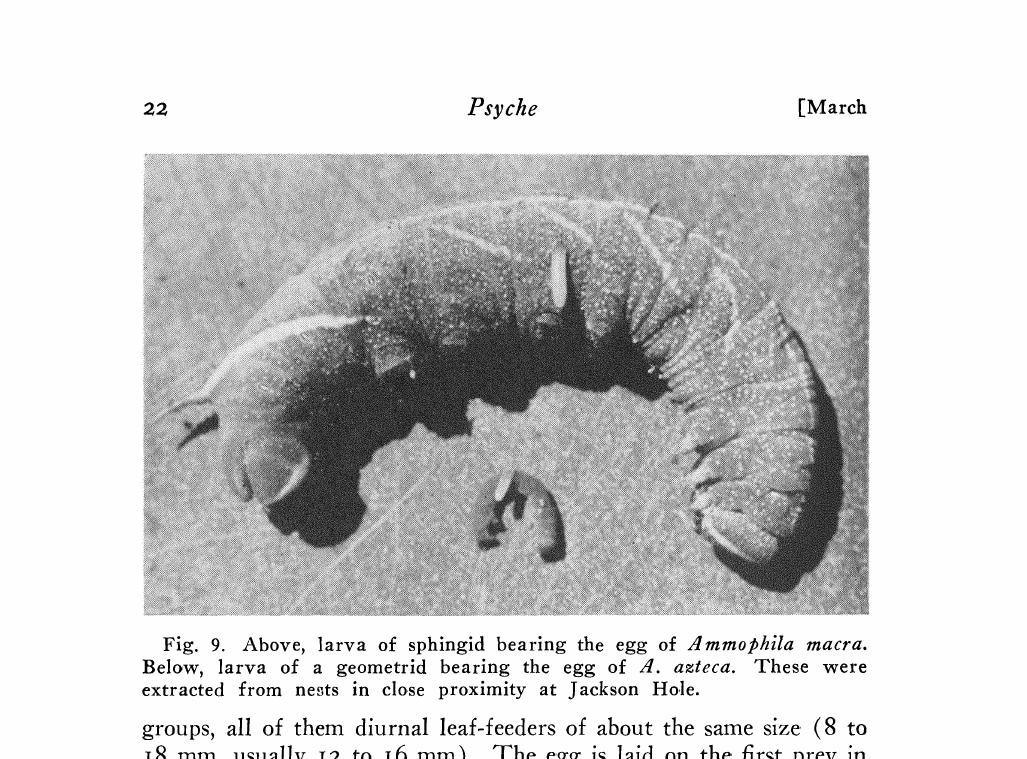
Fig. 9. Above, larva of sphingid bearing the egg of glmmophila macra. Below, larva of a geometrid bearing the egg of .4. azteca. These were extracted from nets in close proximity at Jackson